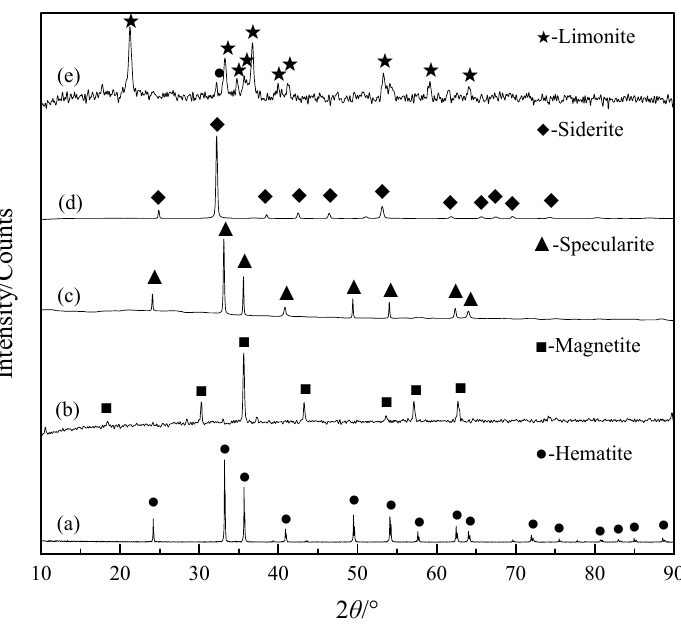
Figure 2. XRD analysis of iron-bearing pure minerals: ( a ) hematite; ( b ) magnetite; ( c ) specularite; ( d ) siderite; ( e ) limonite.